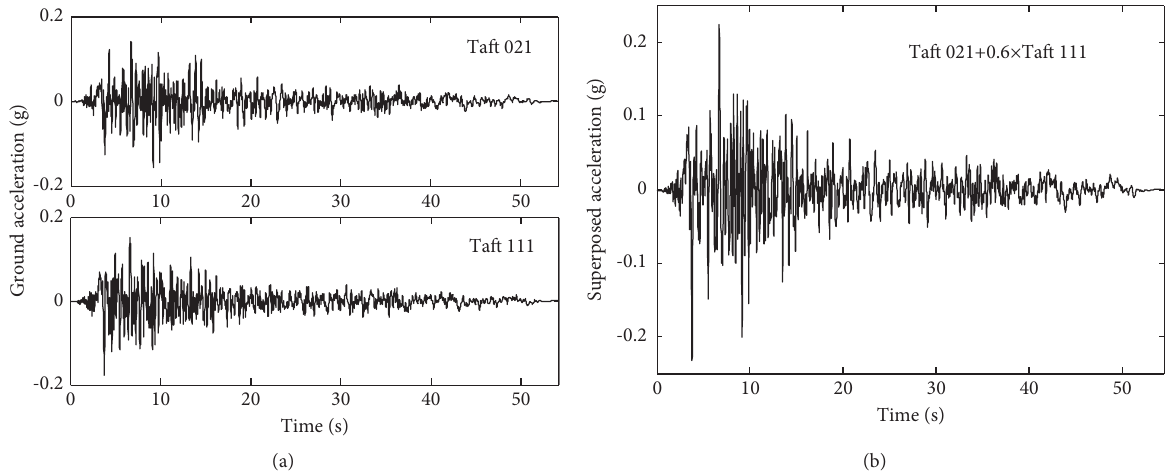
Figure 1: The superposition of bidirectional ground “A” records of Taft. (a) Bidirectional ground “A”s. (b) Superposition of bidirectional “A.”